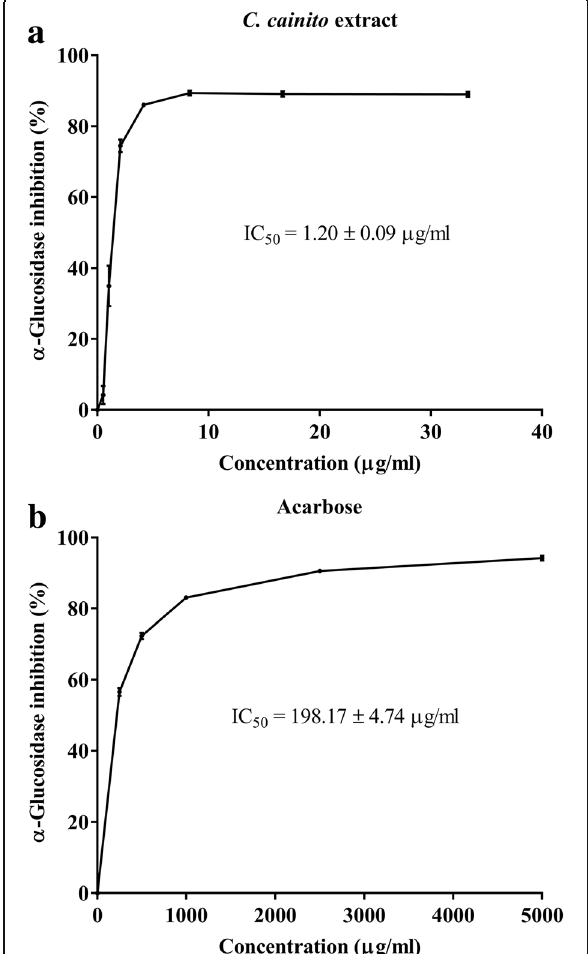
Fig. 6 The effect of C. cainito extract (CE) on α -glucosidase activity. Values are expressed as mean ± S.E.M. of three separate experiments. Acarbose was used as positive control. Panel a and b are results from α -glucosidase inhibitory activities of C. cainito and acarbose, respectively. The calculated IC 50 of the extract was 1.20 ± 0.09 μ g/ml, whereas that of acarbose was 198.17 ± 4.74 μ